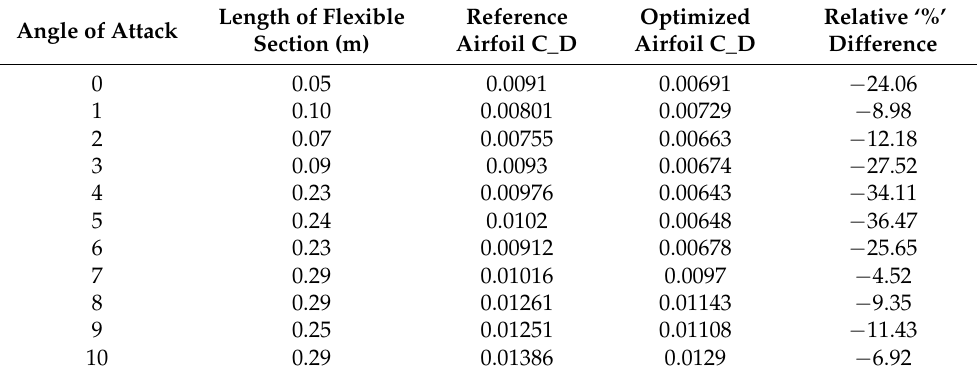
Table 2. Optimized drag results for the reference and optimized morphing airfoils for a certain length of a flexible morphing section for drag minimization.